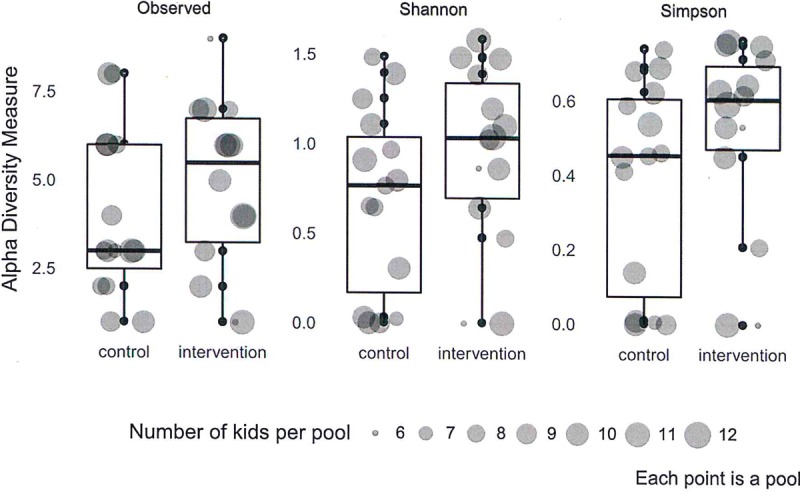
Differences in alpha diversity for the enteric virome between intervention and control groups.